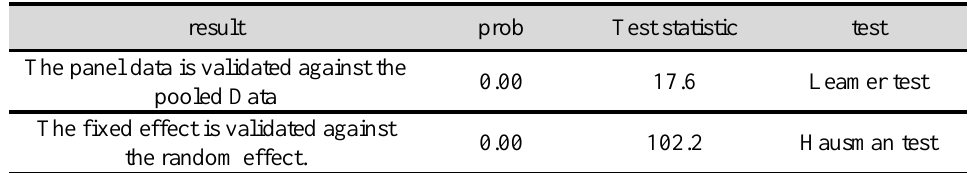
Table 5: Results of the Leamer and Hausman tests